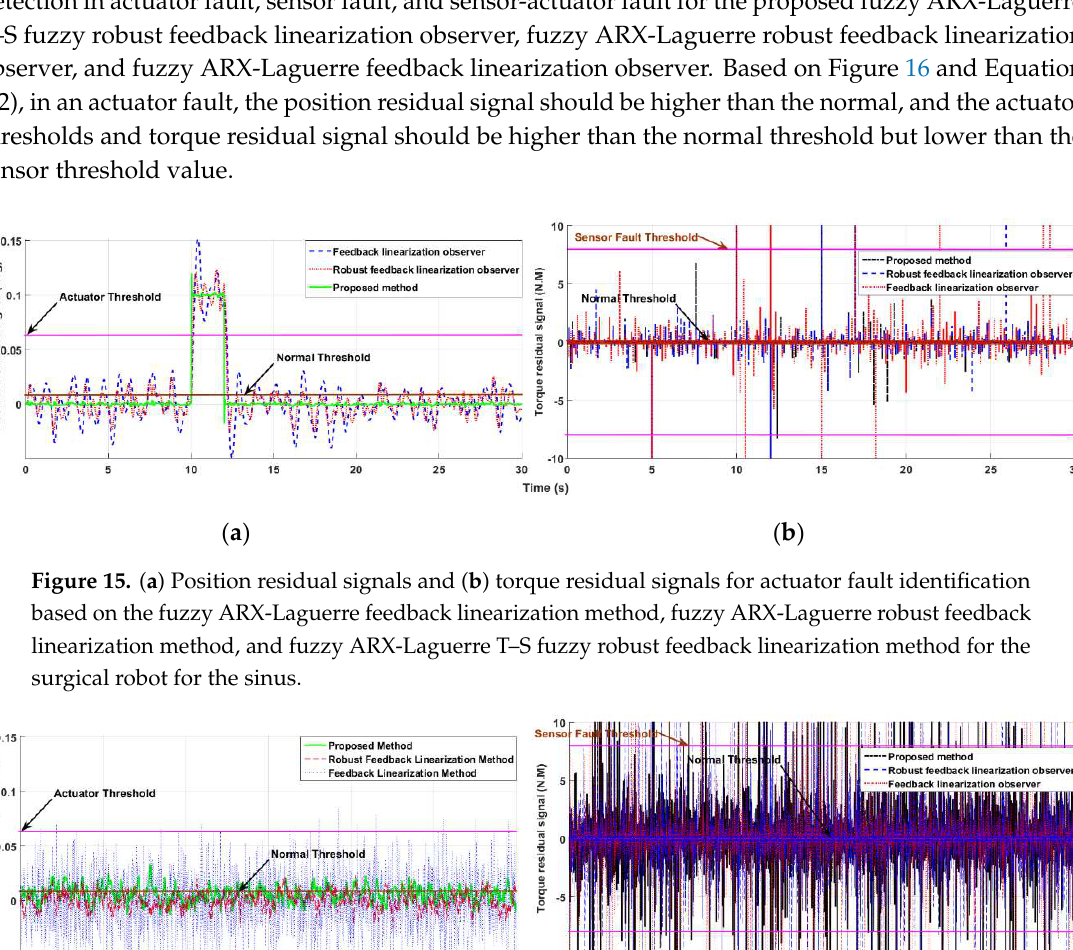
( b ) Figure 17. ( a ) Position residual signals and ( b ) torque residual signals for actuator-sensor fault identification based on the fuzzy ARX-Laguerre feedback linearization method, fuzzy ARX-Laguerre robust feedback linearization method, and fuzzy ARX-Laguerre T–S fuzzy robust feedback linearization method for the surgical robot for the sinus. 4.2. Fault-Tolerant Control The root mean square (RMS) error of the kinematics and the end-effector position for the surgical robot for the sinus in the normal, actuator fault, sensor failure, and actuator-sensor fault conditions are illustrated in Figures 18–21. Based on Figure 18, the RMS error in the normal condition for the end-effector of the surgical robot for the sinus is close to zero. In Figures 19–21, the error rate is greater than at the normal condition. Regarding these figures, the end-effector positions fluctuate similar to in the normal condition. After fault detection, estimation, and identification based on the fuzzy ARX- Laguerre T–S fuzzy robust feedback linearization (proposed) observer, the proposed fault-tolerant control based on the adaptive fuzzy proposed observation-based feedback linearization controller is tested. To test the proposed fault-tolerant controller, the proposed method is compared with the observation-based feedback linearization controller and the classical feedback linearization control algorithm. The main goal in this part is elimination or reduction of the effect of the fault to increase